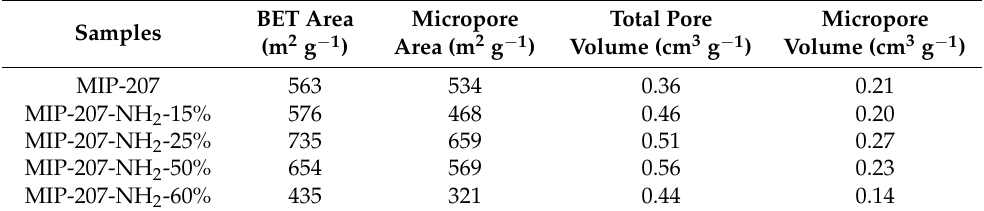
Table 2. The summary of specific surface area, pore volume, and particle size of samples.